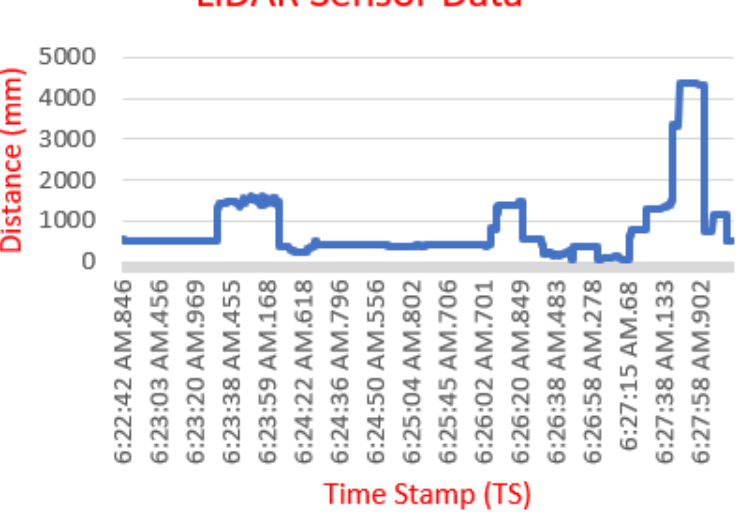
Figure 12. Example of LiDAR sensor data.